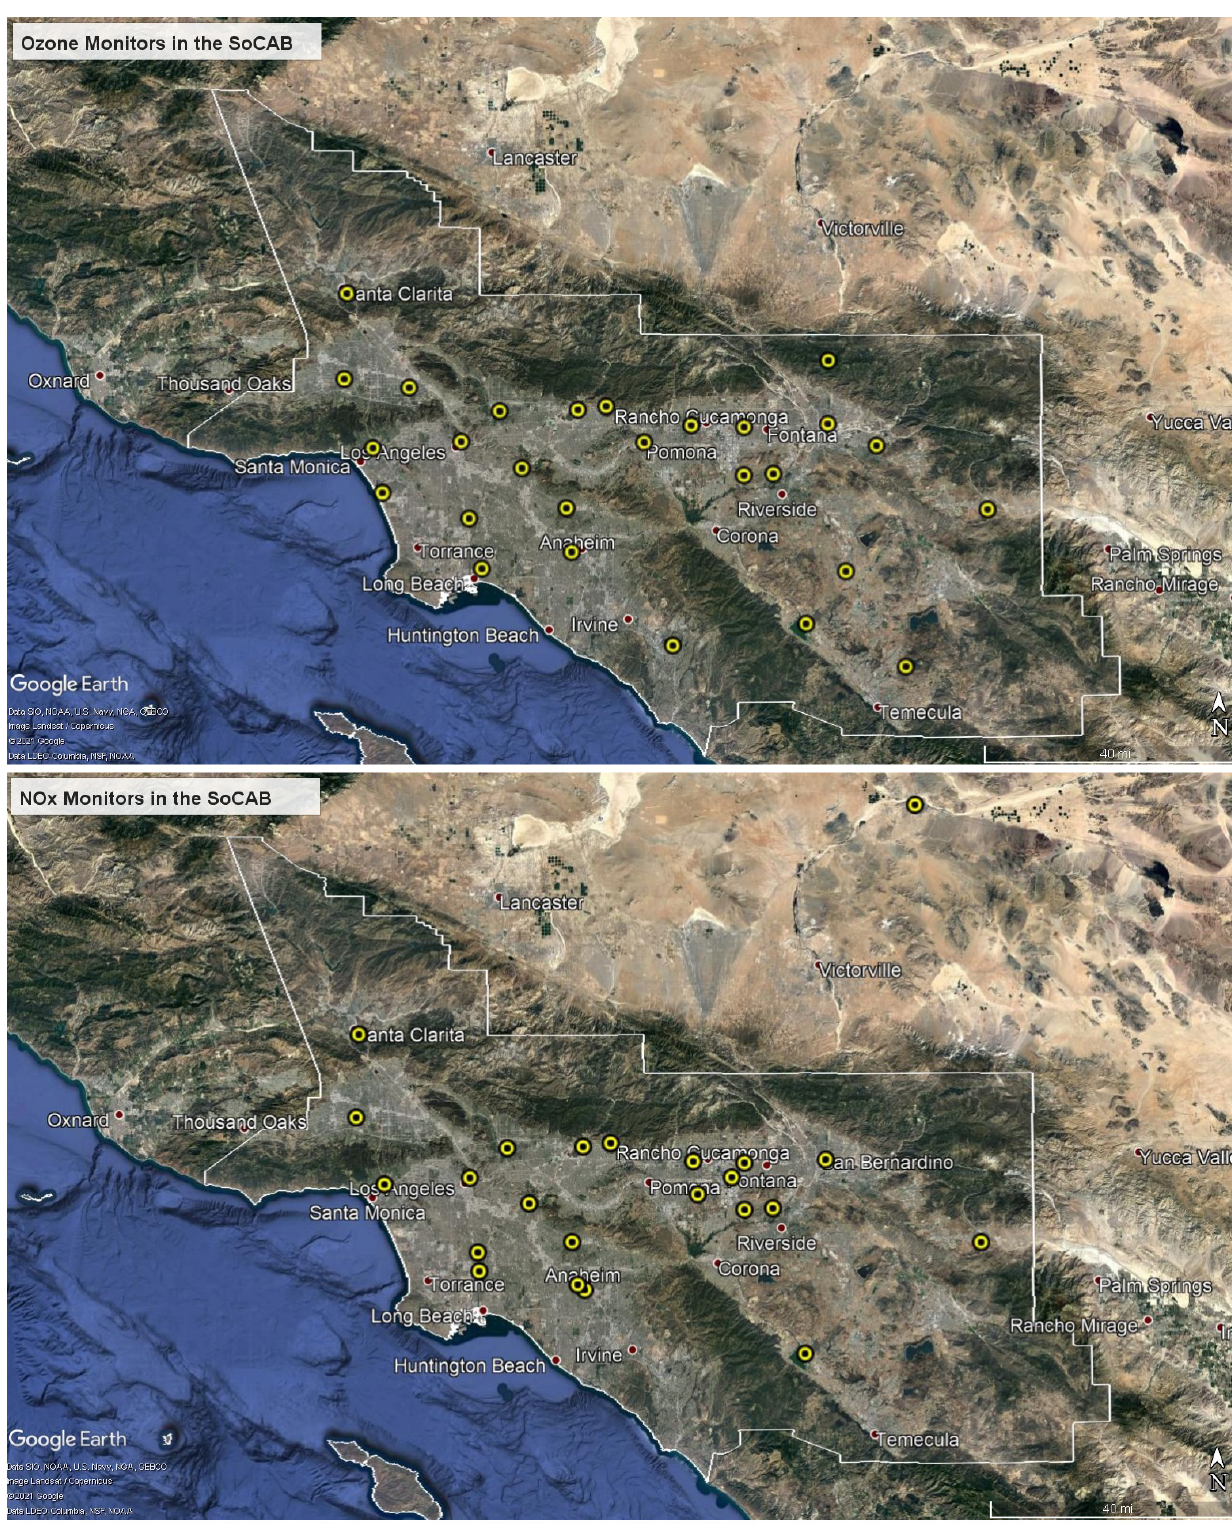
Figure 1. Maps of SoCAB surface O 3 (top) and NO 2 (bottom) monitors . The outline of the SoCAB boundary is shown as a white polygon.